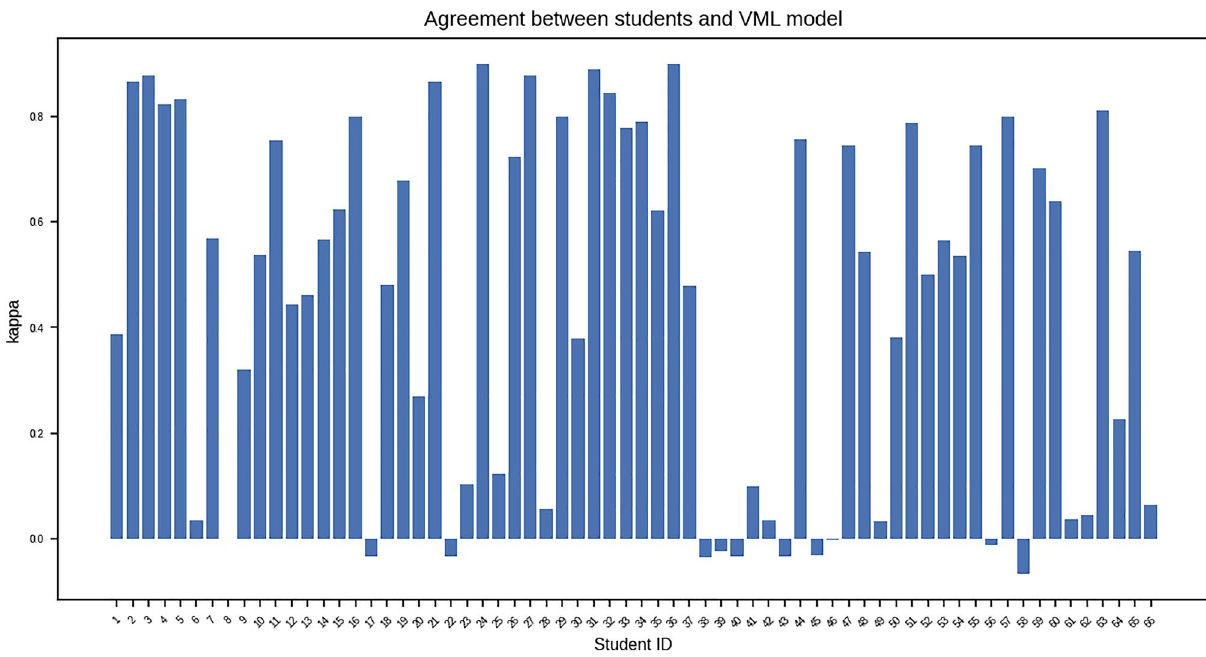
Figure 9. Plot of Cohen’s kappa for each student (n = 66), as a measure of agreement between students and VML model (Figure generated by Matplotlib python library, version 3.3.4, https:// matpl otlib.